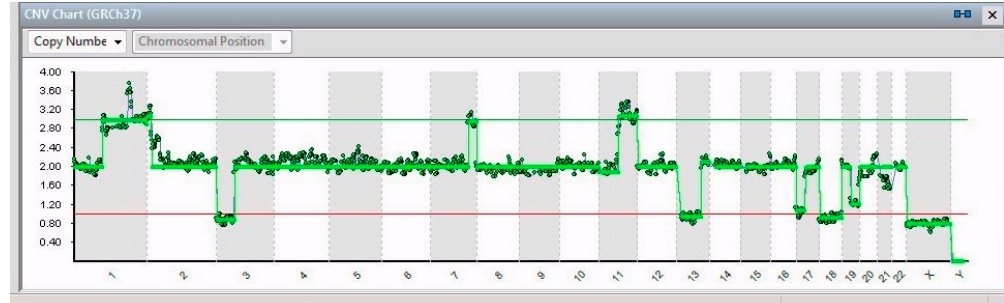
Figure 2. CNV chart related to a single cell from IMR-32 showing, from left to right, partial gain of chromosome 1, total gain of chromosome 6, partial gain of chromosome 15, a partial loss of chromosome 16, a partial gain of chromosome 17, and the total loss of the X chromosome. All 14 isolated single cells from SK-N-BE (2)-C presented a partial gain of chromosomes 7 (7q32.1–q36.3 of 27 Mb) and 11 (11q13.3–11q25 of 65 Mb), a total loss of X chromosome, and a partial loss of chromosomes 3 (3p26.3–3p14.2 of 61 Mb), 13 (13q12.11–13q31 of 66 Mb), 17 (17p13.3–17q11.2 of 30 Mb), 19 (19q12–19q13.43 of 28 Mb) and 21 (21q22.2–q22.3 of 6 Mb). In 8/14 cells, a partial gain of chromosome 1 was found (1p32.3–1q44 of 151 Mb) (Figure 3); moreover, 5/14 cells showed a partial loss in that chromosome (1p32.2–1p21.3 of 44 Mb) (Figure 4); showed a peculiar gain of chromosome 9, i.e., 9p24.3–9p23 (13 Mb).